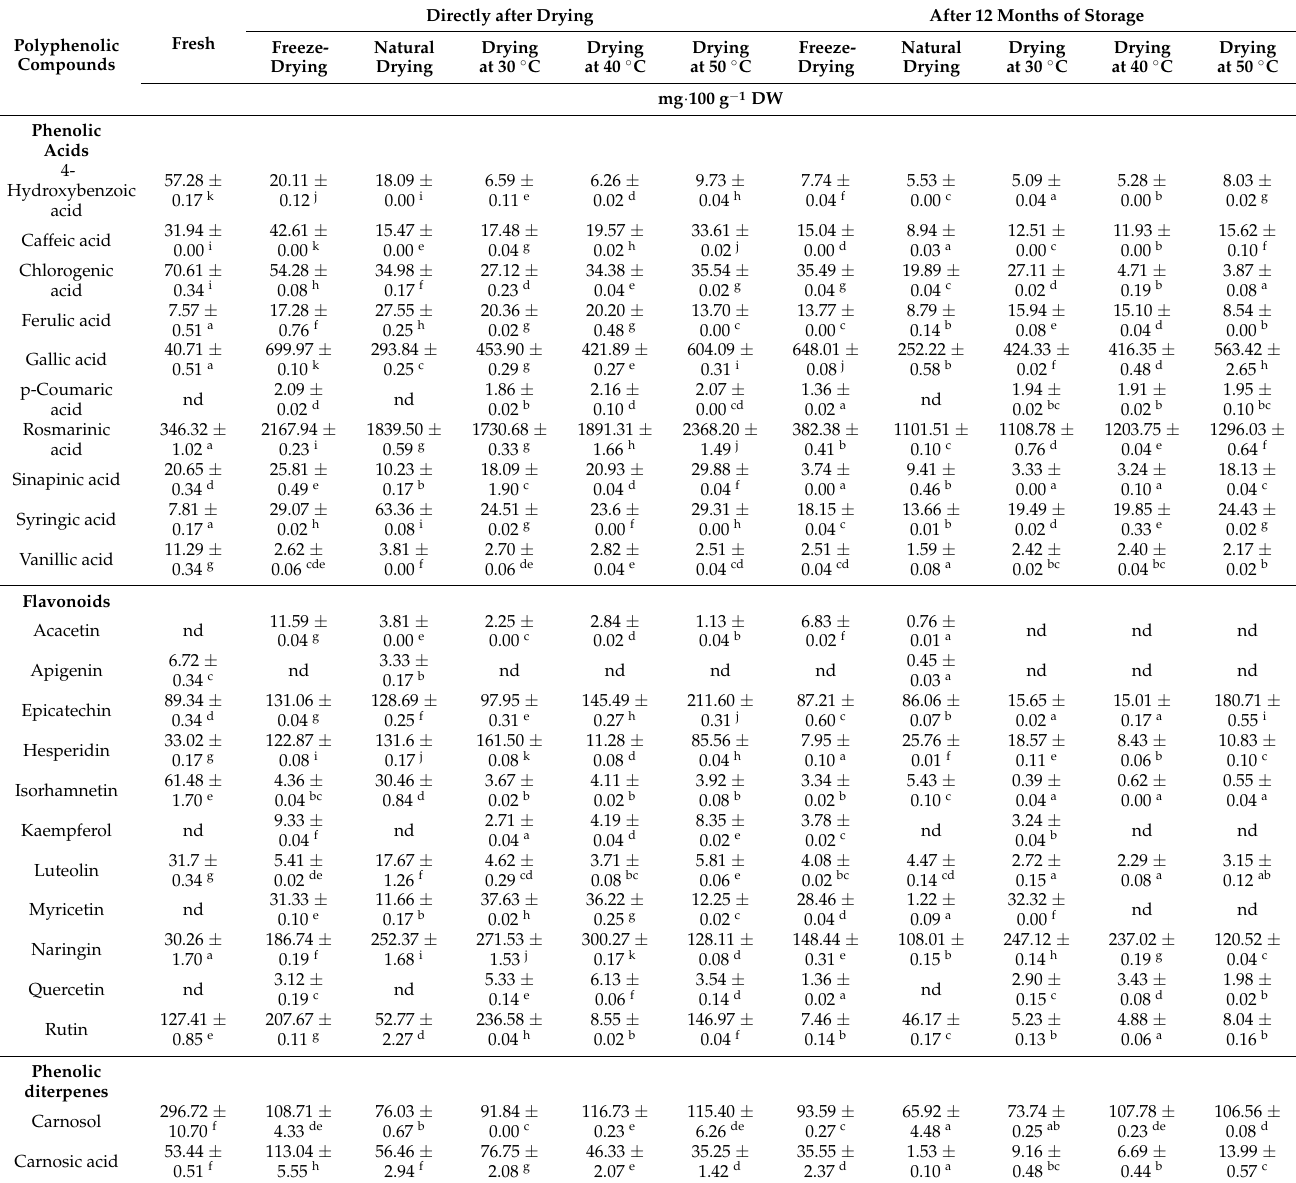
Table 7. Concentration of individual polyphenolic compounds in fresh, dried, and stored Salvia sclarea